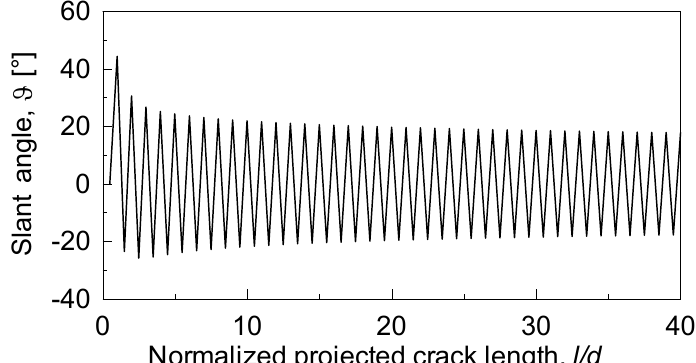
Figure 3: Example of slant angle variation under nominally Mode I loading ( d = characteristic material length).